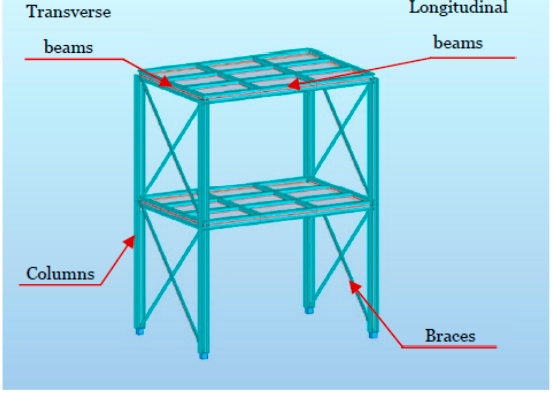
Figure 1. Isometric view of the structural model.